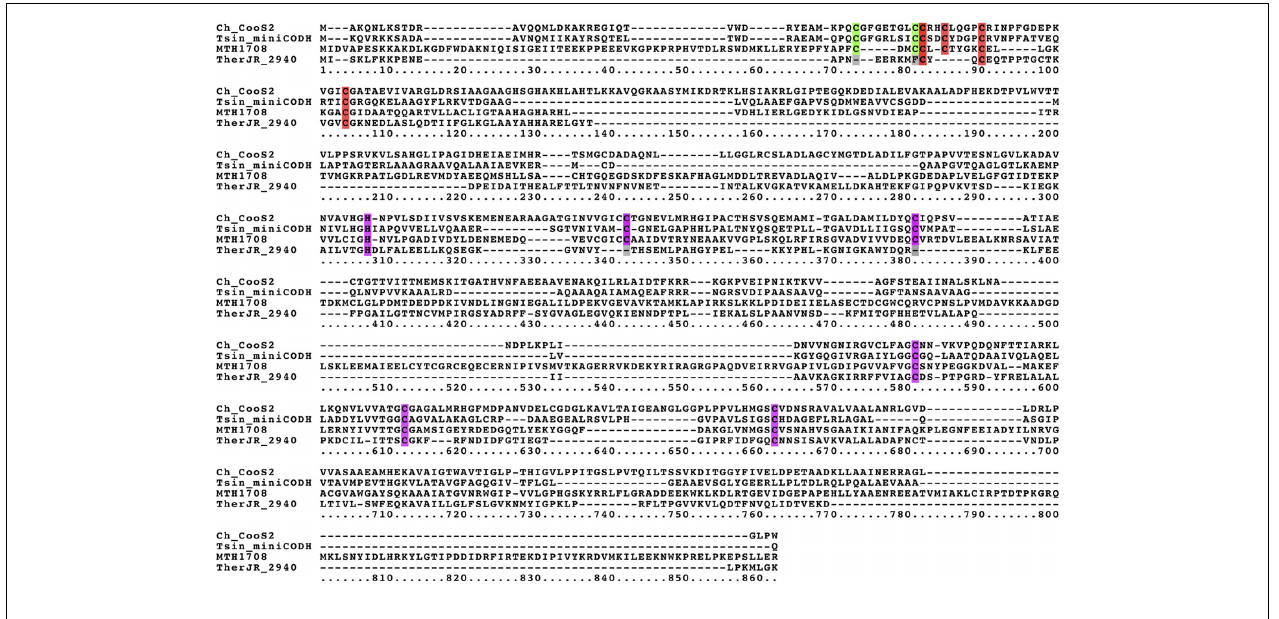
three sites as being essential for CooS activity. Cluster C (purple), B (red), and D (green). All of these residues are present in the C. hydrogenoformans CooS-II, M. thermoautotrophicus Cdh, and T. carboxydivorans minimal CooS. Many of these residues are absent in the hydroxylamine reductase.The sequences were aligned with MAFFT v6.861b (http://mafft.cbrc.jp/alignment/server/index.html).